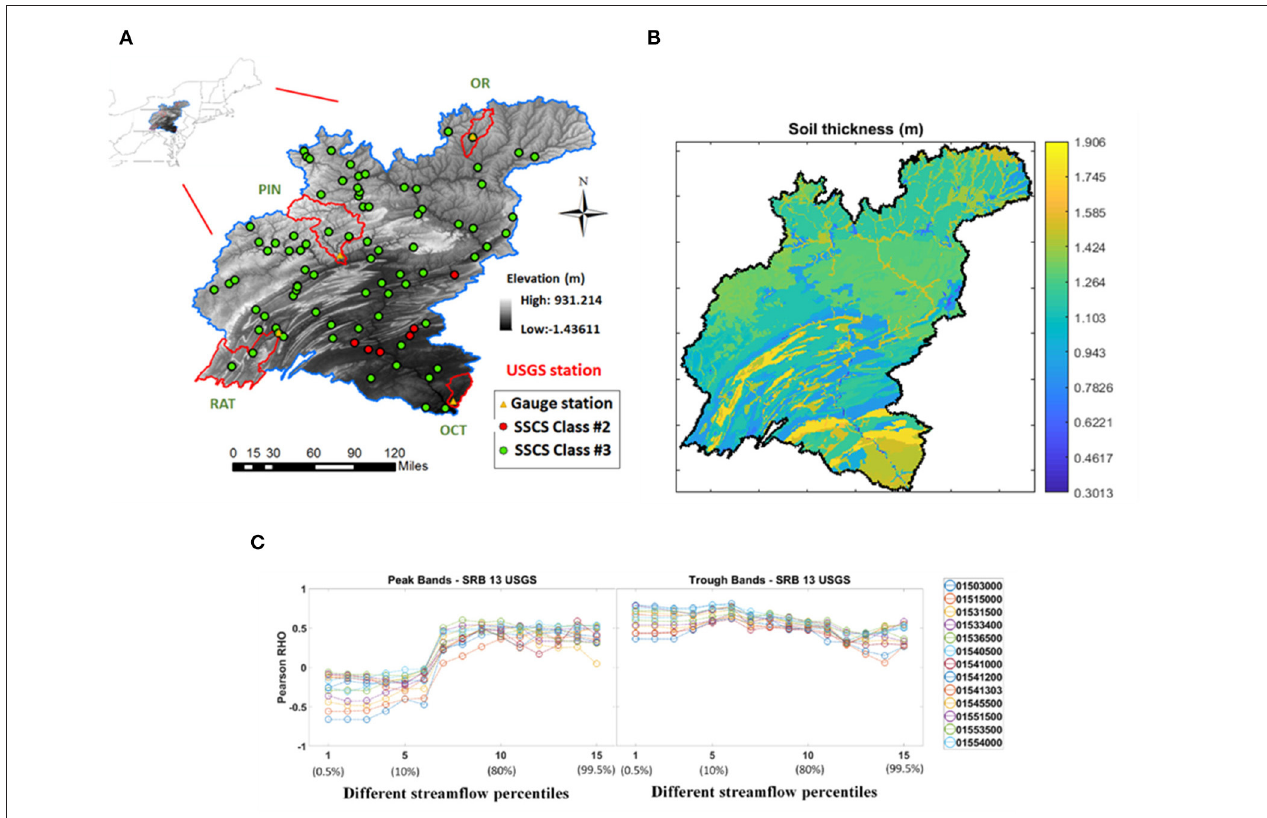
FIGURE 3 | Study area, Susquehanna River Basin (SRB). Main class of SRB observation data is class #3 and #2 in FS17. (A) Study area, Susquehanna River Basin. Among the subbasins modeled, OR and PIN are headwater subbasins in the Appalachian Plateau, RAY is a headwater subbasin in the Valley and Ridge physiographic division, and OCT is near the Coastal Plain region. (B) Soil thickness. (C) SSCS in Susquehanna River Basin for 13 USGS gauge stations (station numbers in